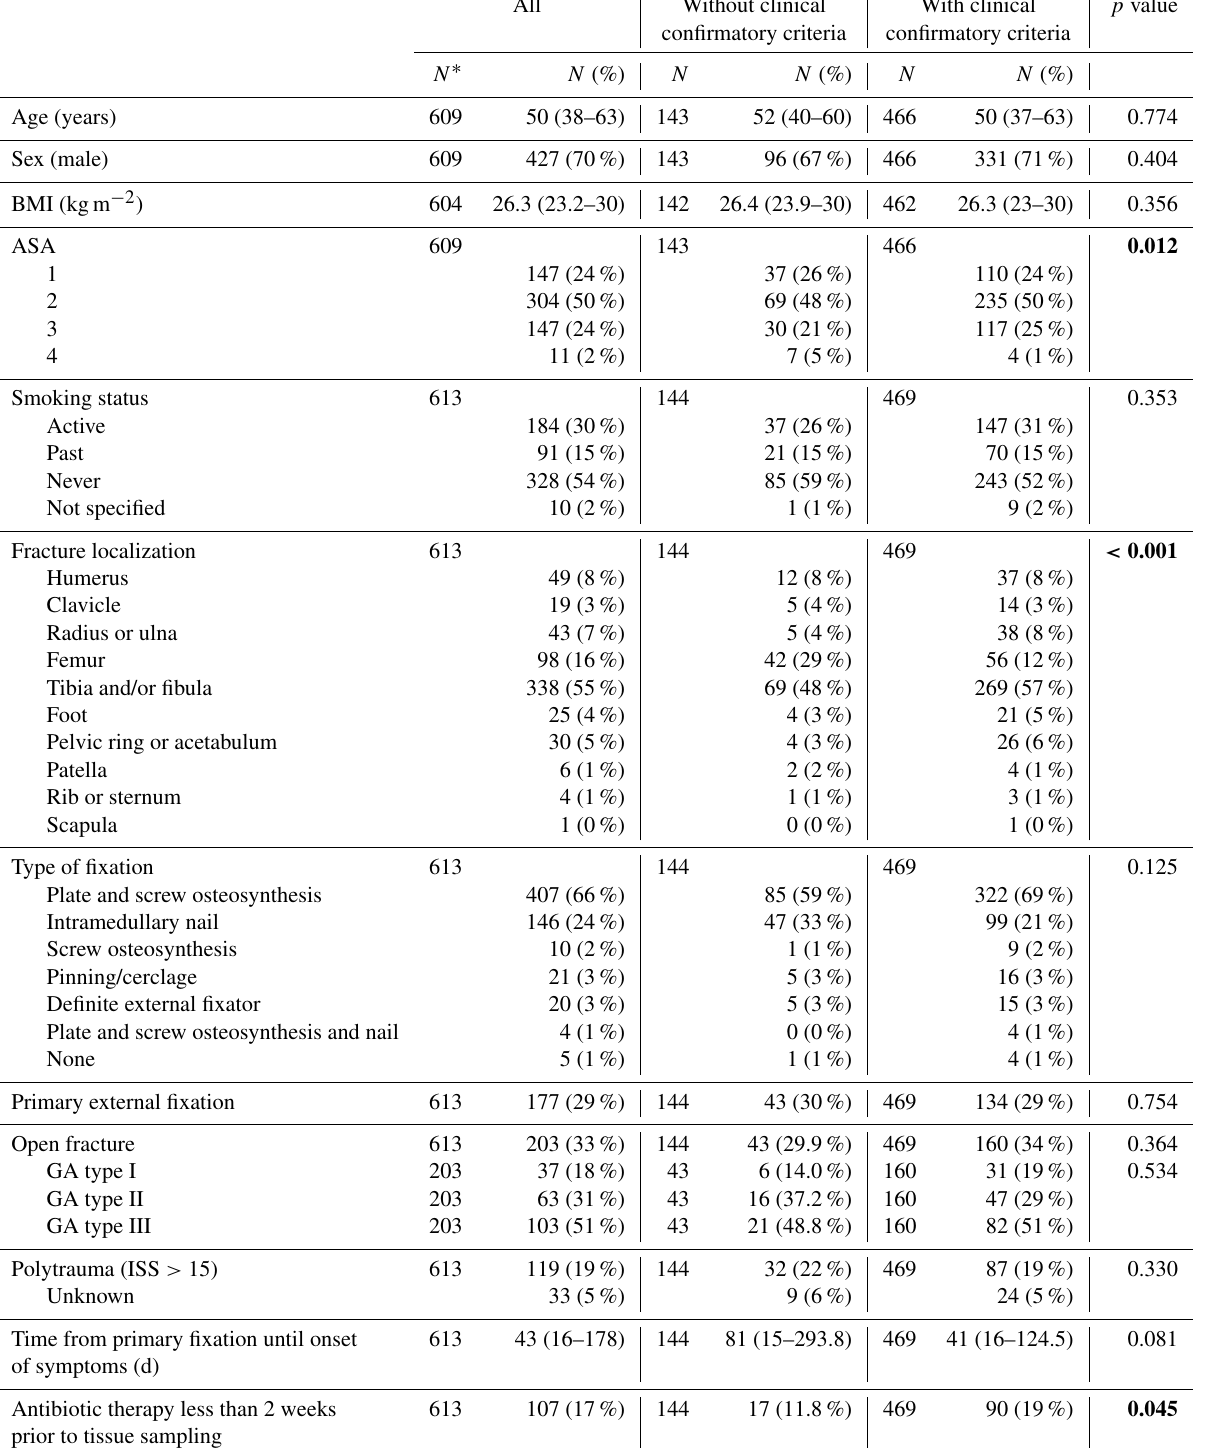
Table 2. Patient characteristics. Statistically significant p values are displayed in bold. All Without clinical With